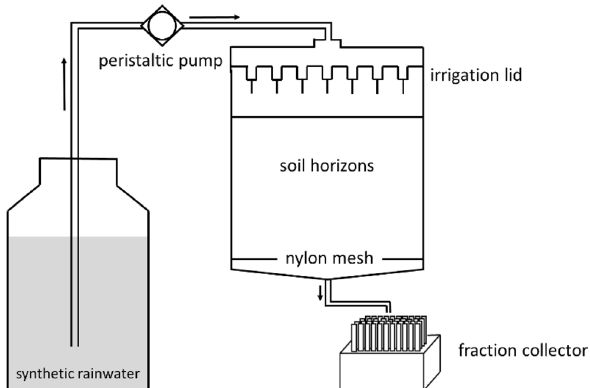
Figure 1. Schematic illustration of the experimental setup of the irrigation